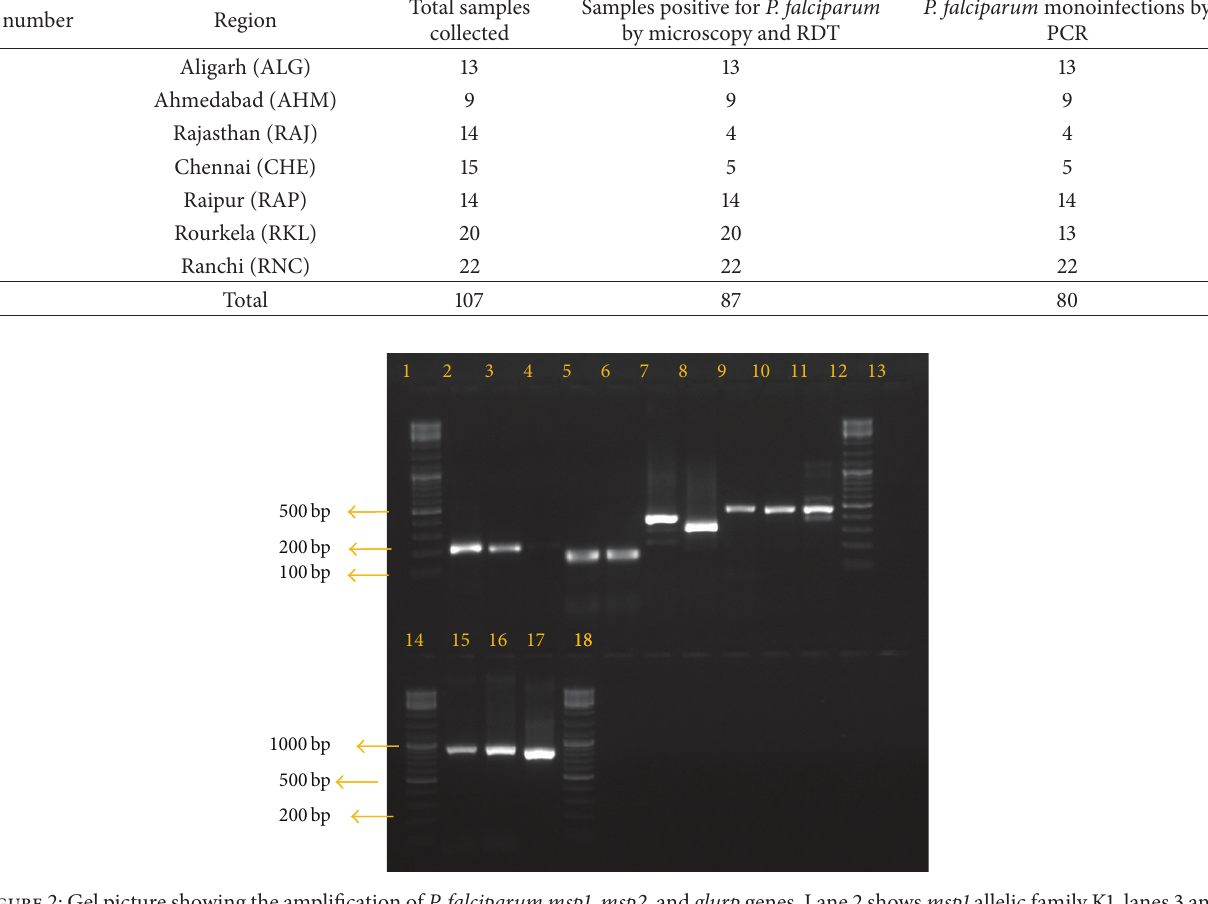
Table 1: Summary of the P. falciparum isolates collected from various regions across India. S. number